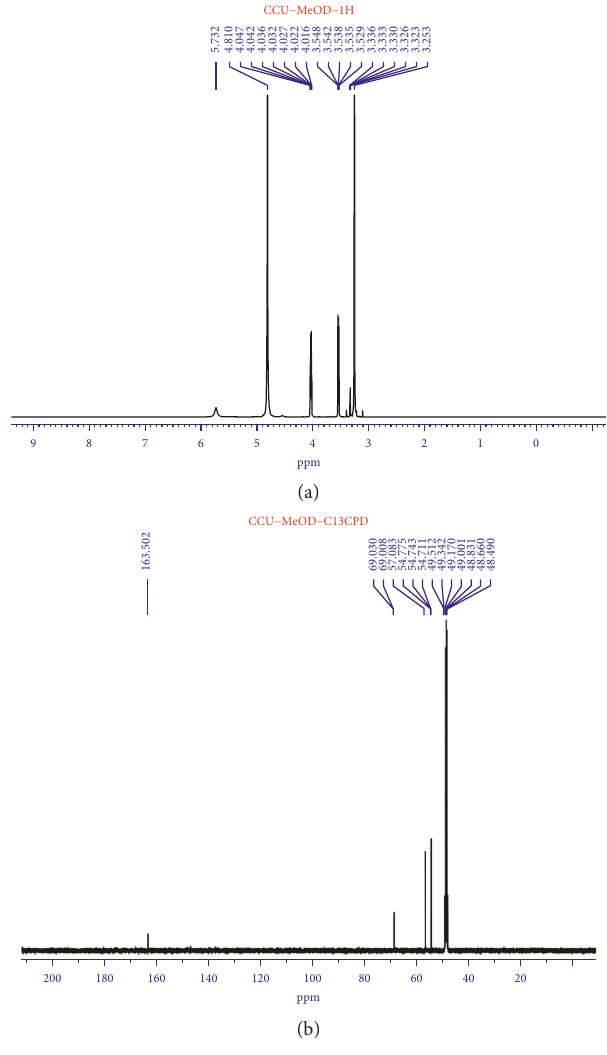
Figure 4: NMRspectrumofDES(1:1): 1 HNMR(a)and 13